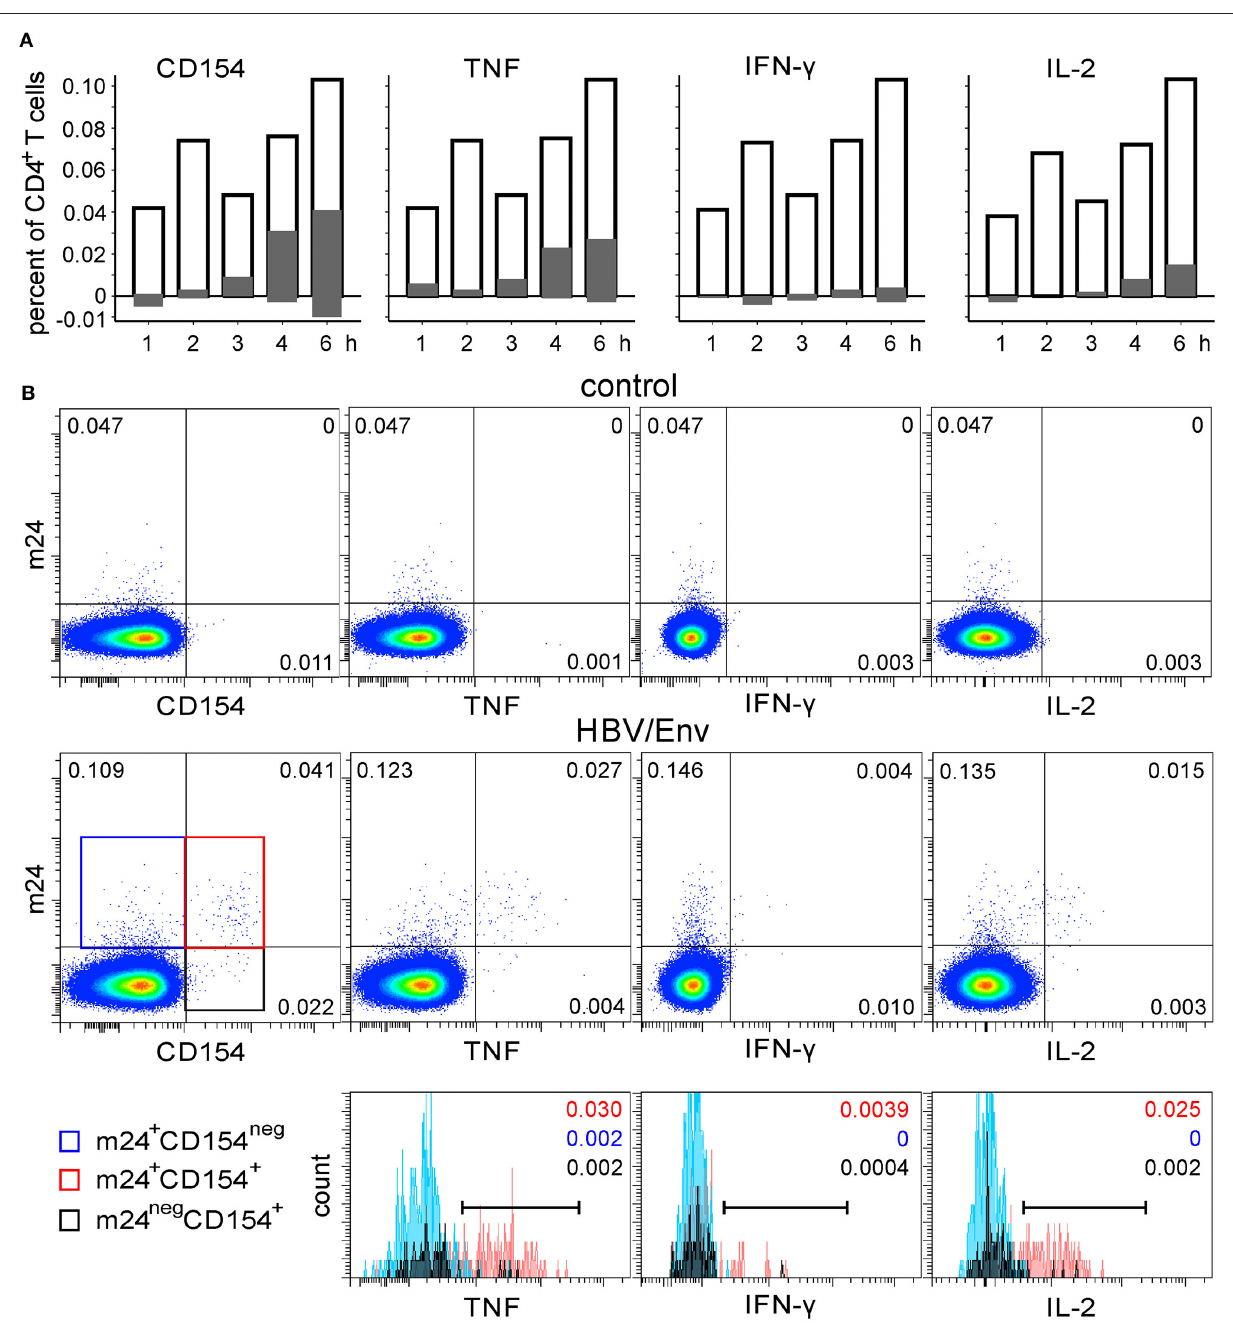
FIGURE 6 | The functional profile of HBV-specific m24 + CD4 + WB T cells. The WB from a donor who was vaccinated ∼ 10 years ago against HBV was stimulated with HBV/Env overlapping peptides. (A) Frequencies of m24 Ab staining, CD154, and cytokine expression within CD4 + T cells are shown as bar graphs (at the indicated times and after subtraction of the background assessed in the control test); empty bars represent total m24 + cells, positive gray bars represent marker + (CD154, TNF, IFN- γ , or IL-2) m24 + CD4 + T cells, whereas negative gray bars are marker + m24 neg CD4 + T cells. (B) Staining obtained after 6h without stimulation (control, top) or in the presence of the HBV/Env overlapping peptides (middle). Numbers on density plots indicate frequencies among CD4 + T cells. m24 + CD154 neg , m24 + CD154 + , and m24 neg CD154 + subsets were gated (middle panel: blue, red, and black frames, respectively) and further displayed as histograms according to their TNF, IFN- γ , and IL-2 expression (bottom). Numbers on histograms indicate frequencies of the respective color-coded population among CD4 + T cells (markers are shown). Gating strategy is as shown in Figure 1A .